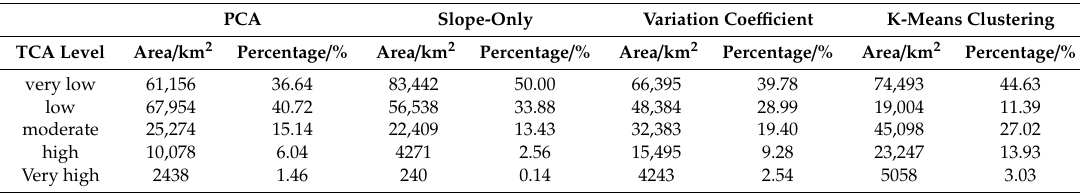
Table 5. TCA results of the four models.